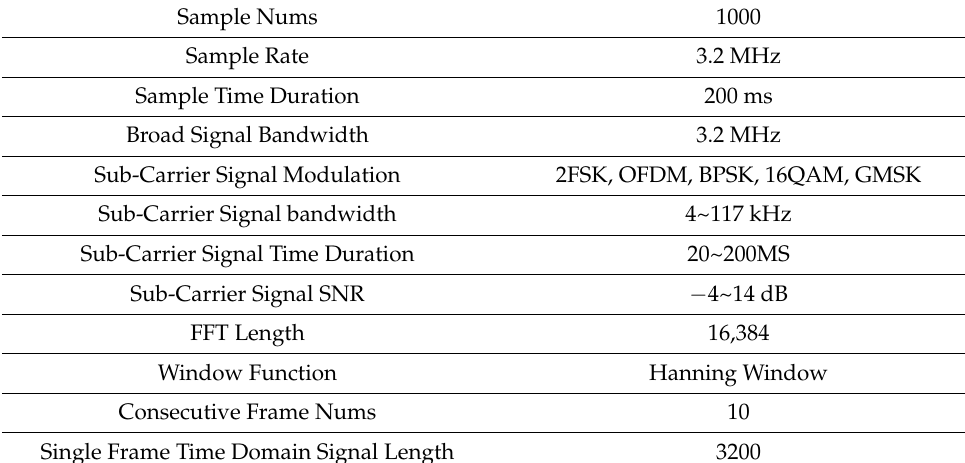
Table 2. Specification for the dataset in this